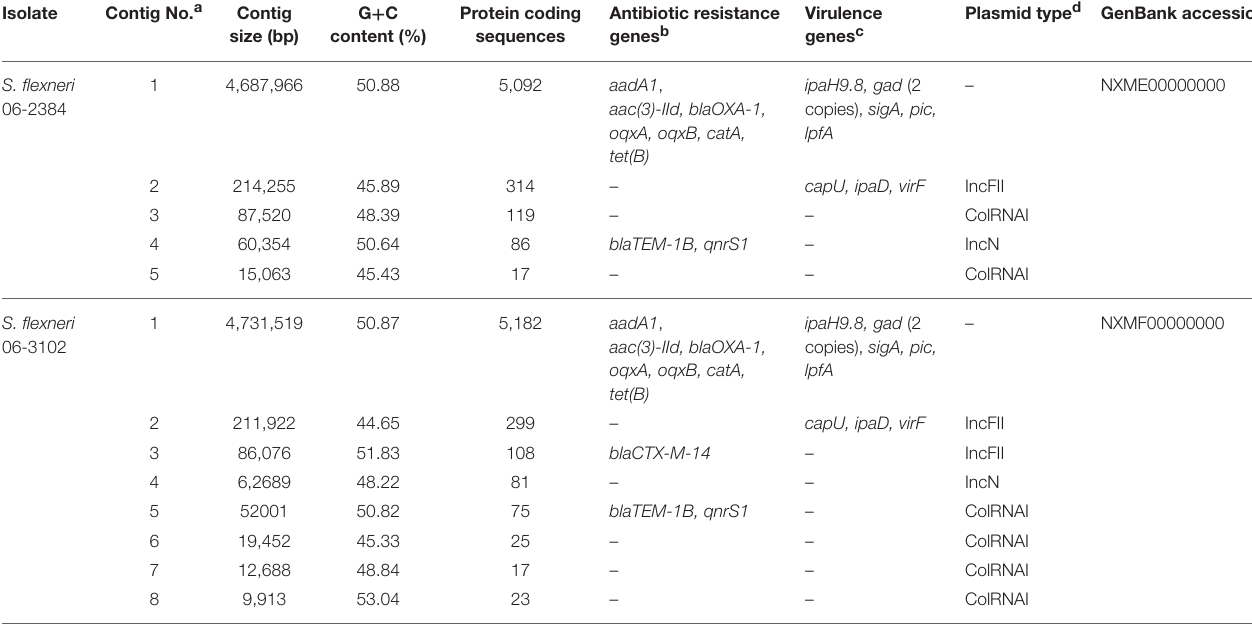
a Graphical circular maps of the chromosome and plasmid sequences available in Supplementary Figure 3. b Antibiotic resistance genes detected using ResFinder 2.1.